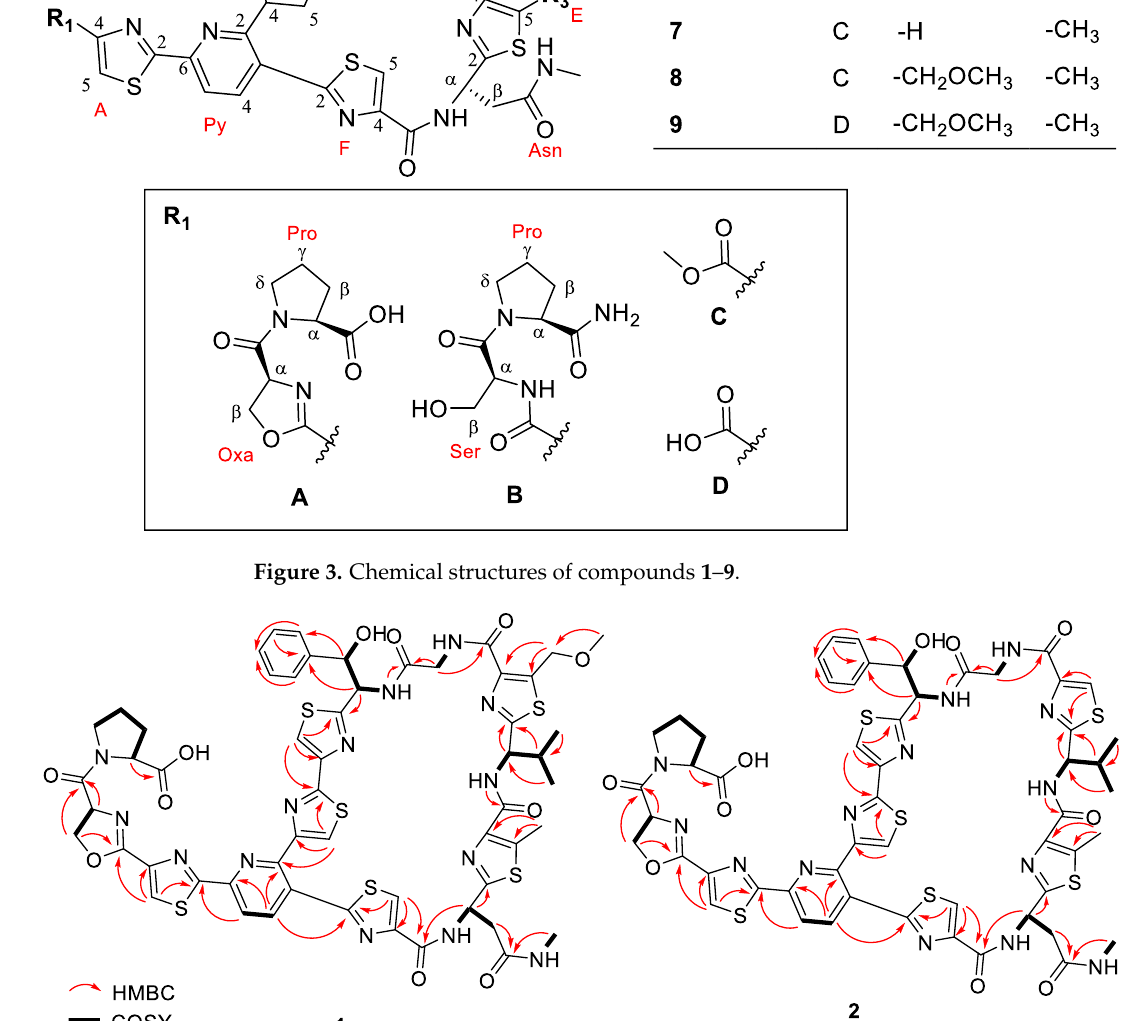
Figure 4. Selected COSY and HMBC correlations of 1 and 2 .